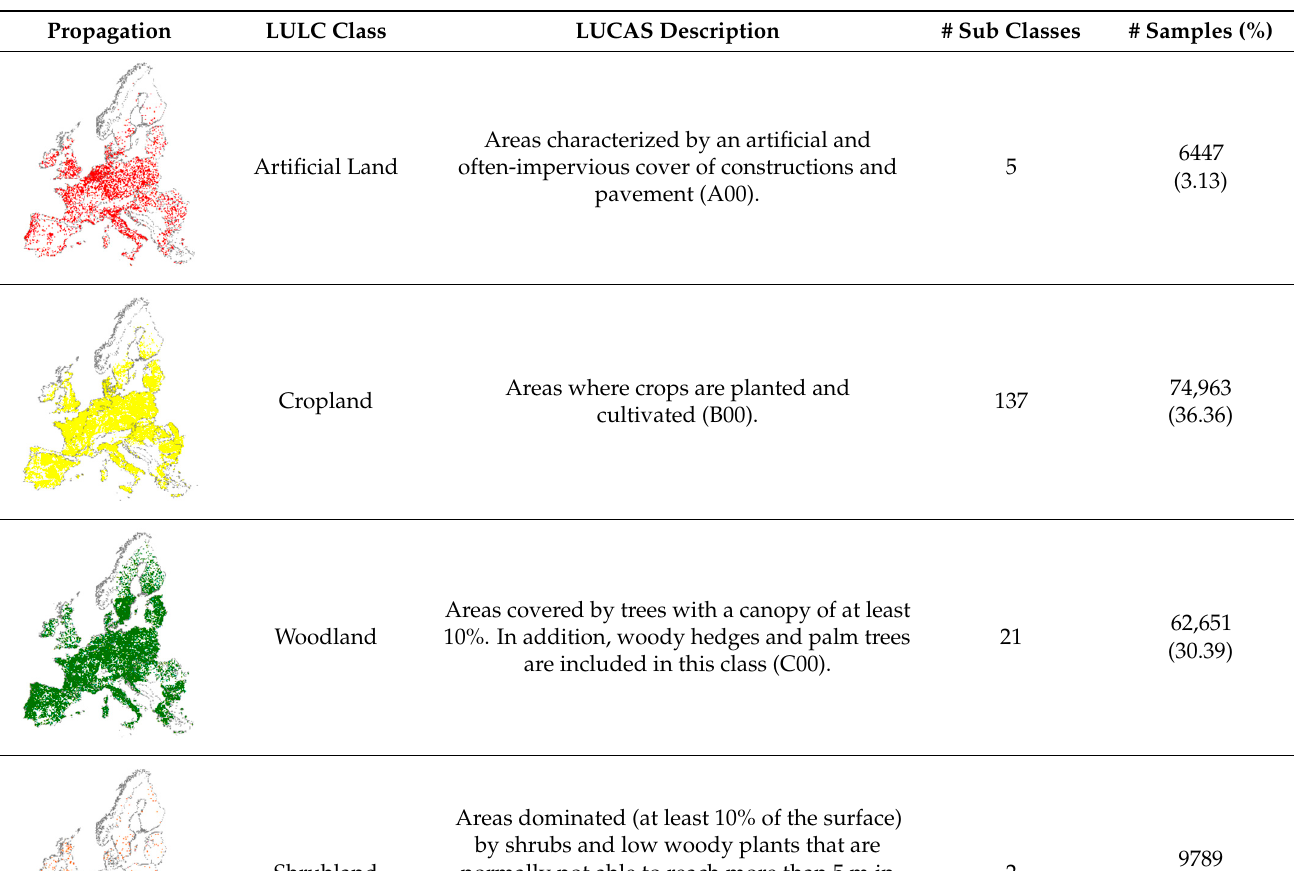
Table 2. The description and number of nine LUCAS classes and subclasses.